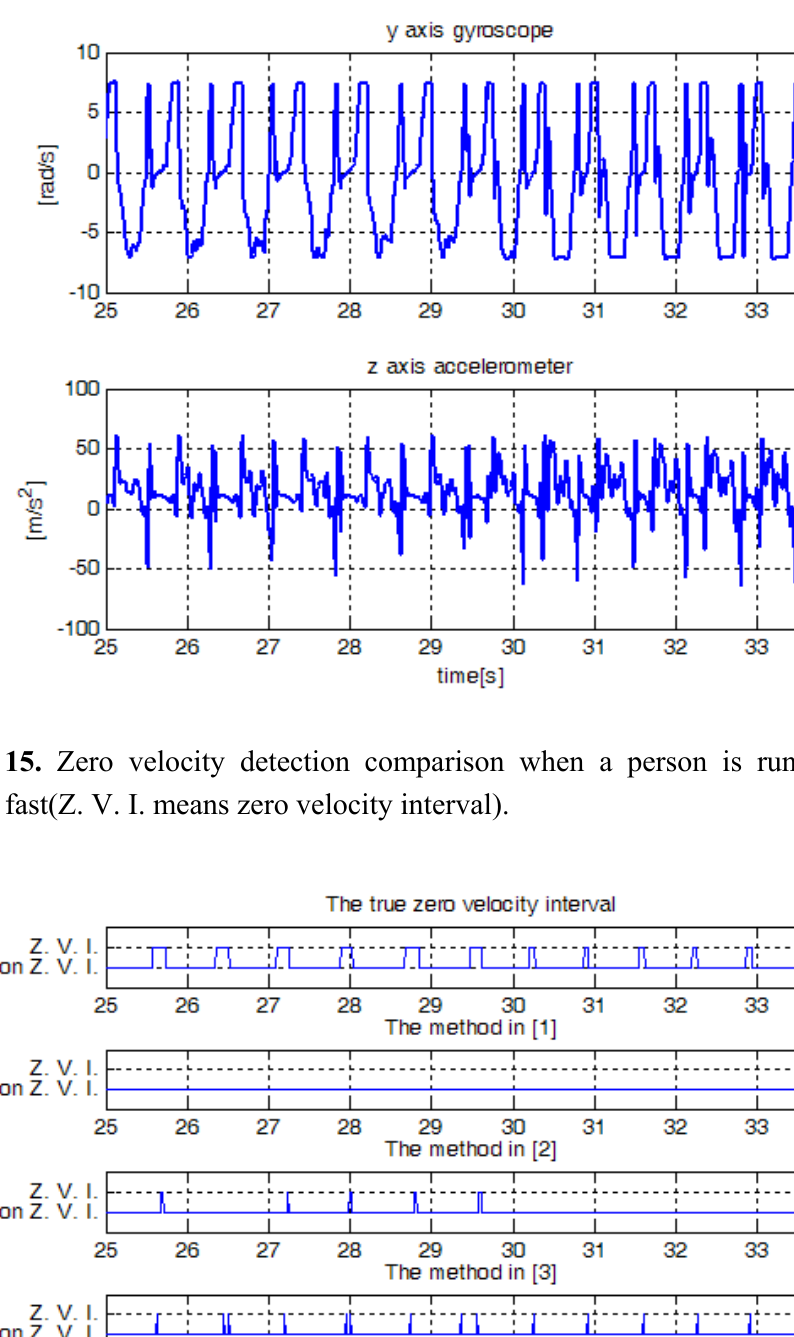
Figure 14. Sensor outputs when a person is running slowly(25~30s) and running fast(30~34 s).